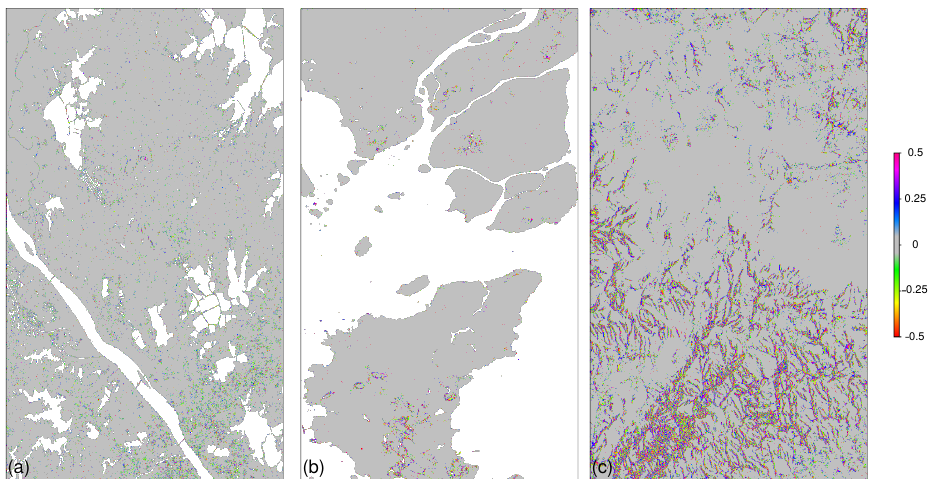
Figure 14. The wrapped phase difference between our diffused results and the wrapped phase for the data of Wuhan ( a ), Singapore ( b ), and Songshan ( c ).